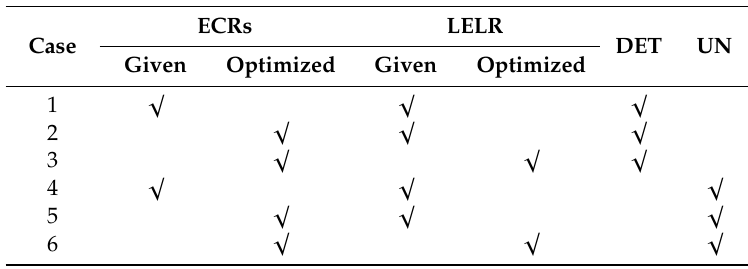
Table 2. Simulated cases.